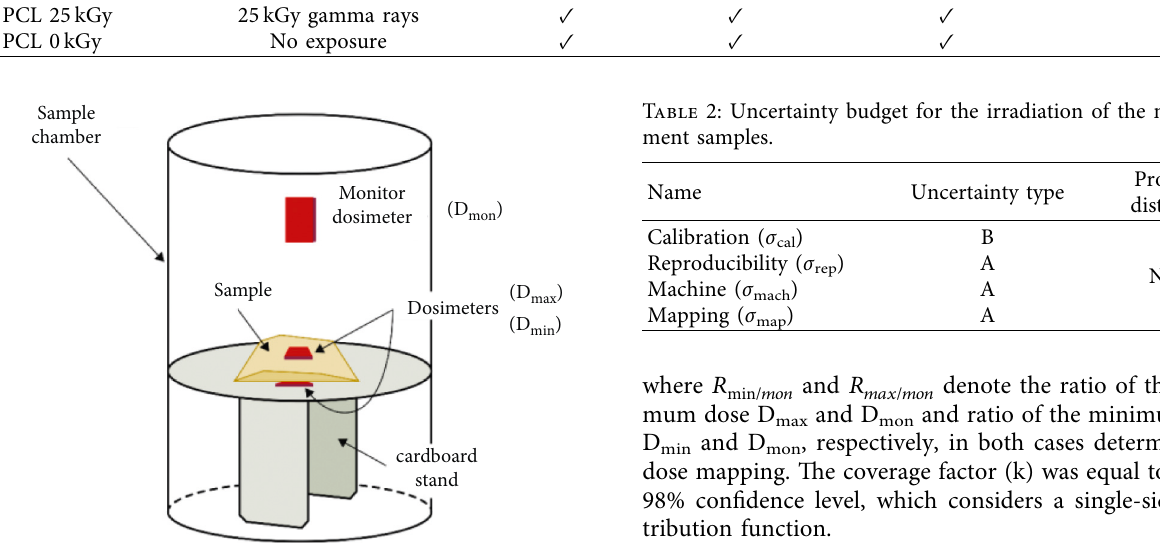
Figure 1: Sample and dosimeters inside the irradiation chamber of the Ob Servo Ignis.